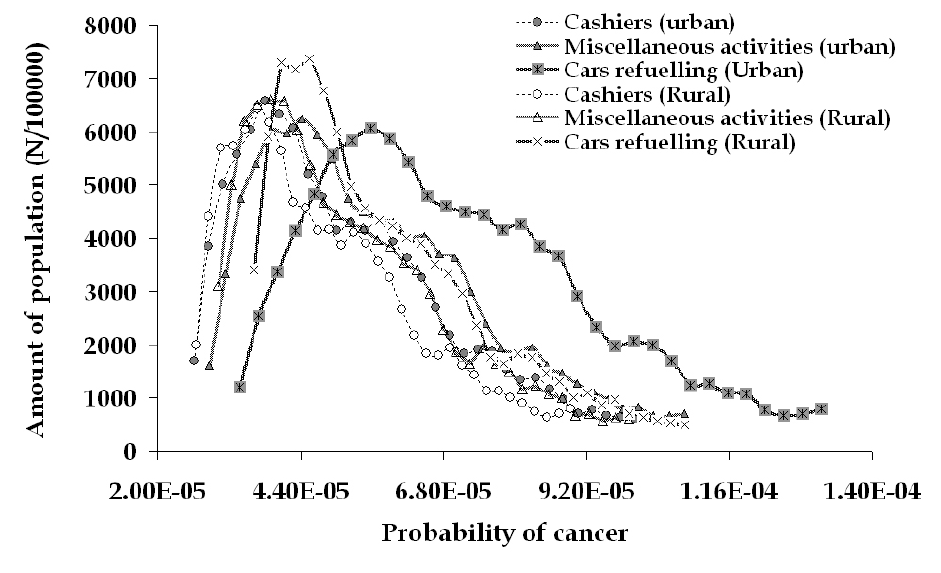
Figure 11. Estimated risk of leukaemia for the general population compared to the filling station employees based on the individual main activities (based on active sampling